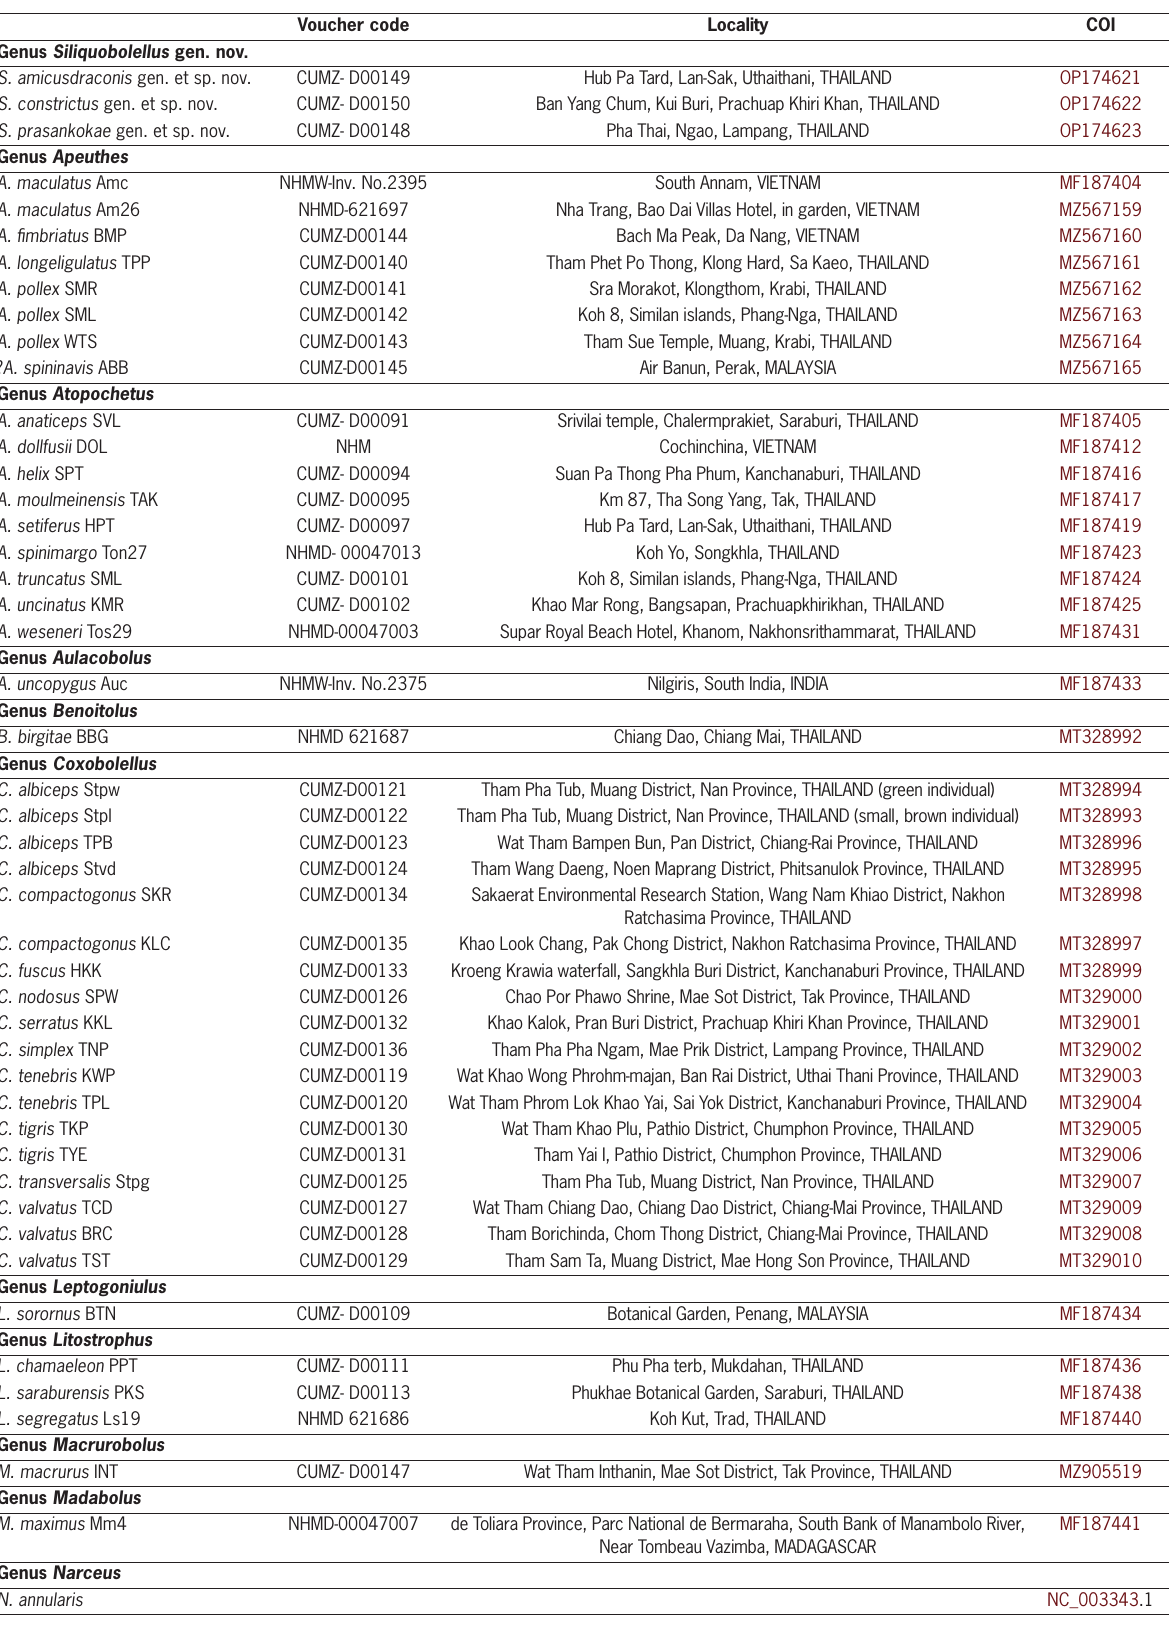
Table 1. Specimens from which the COI gene fragment was sequenced. CUMZ, Museum of Zoology, Chulalongkorn University, Bangkok, Thailand; NHMD, Natural History Museum of Denmark; NHMW, Naturhistorisches Museum, Vienna, Austria; NHM, The Natural History Museum, London, United Kingdom. Names of countries are in capitals. Abbreviations after species names refer to the isolate of each sequence. GenBank accession numbers are indicated for each